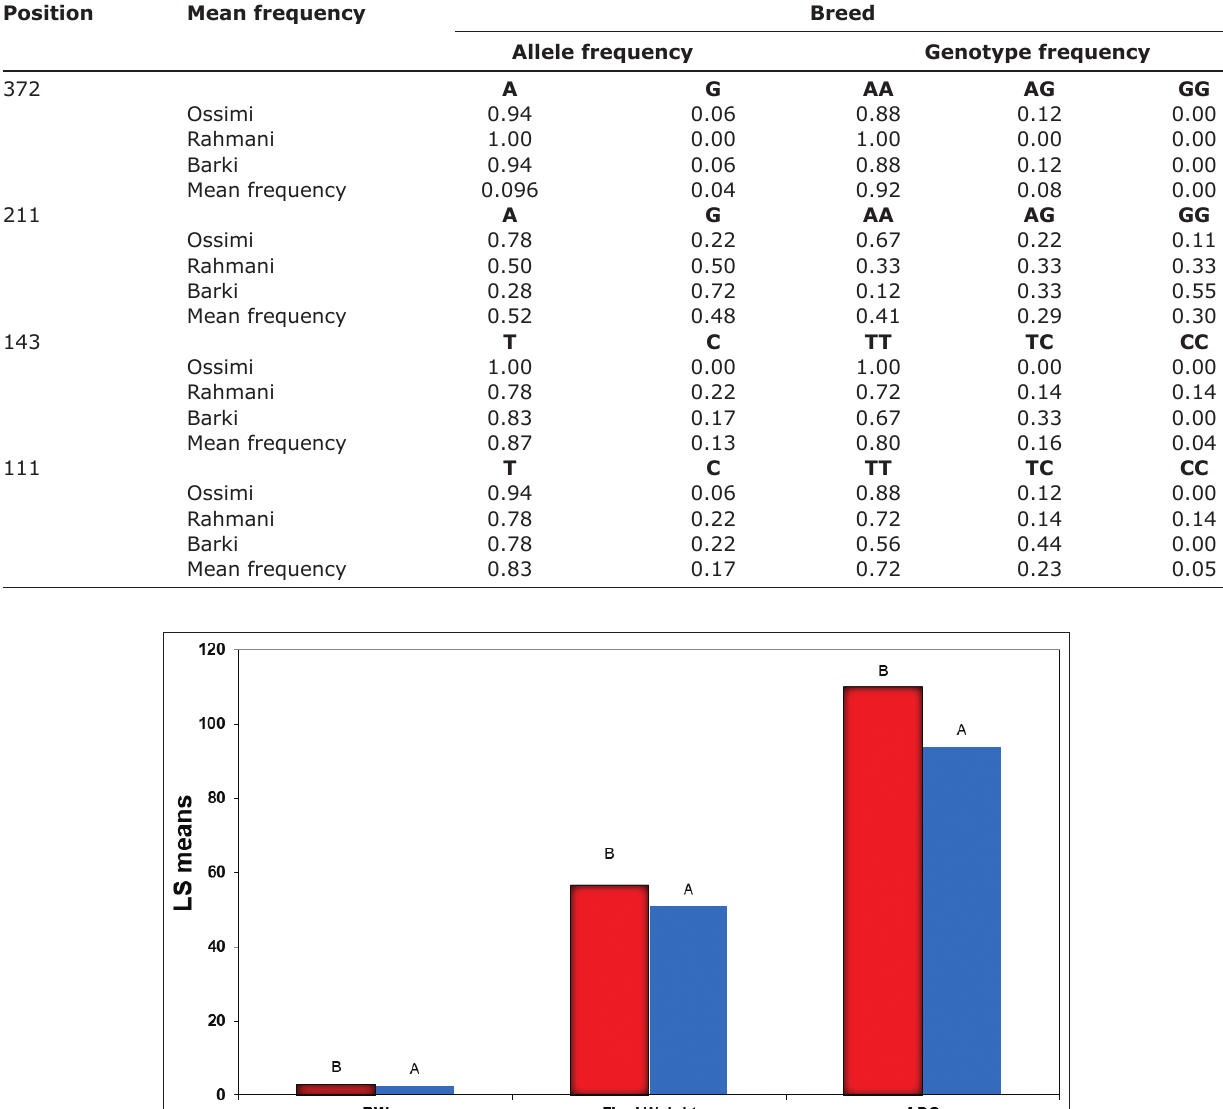
Table-3: Allele and genotype frequencies at each of the four polymorphic nucleotide positions.